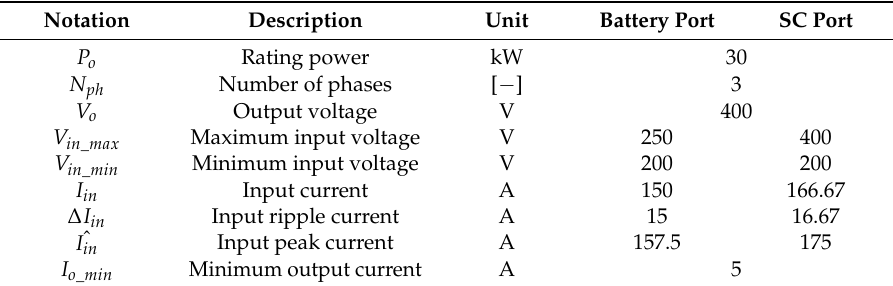
Table 1. Design specification for MPC.